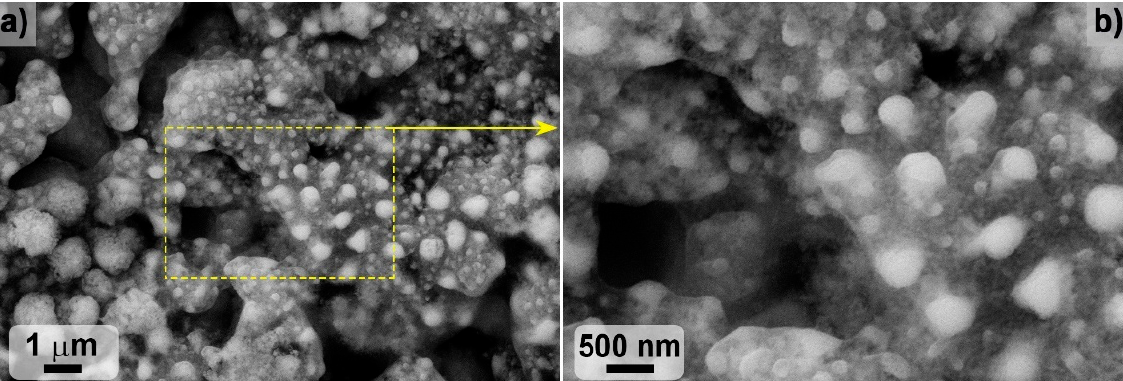
Figure 9. ( a ) ZHSC surface microstructure after thermochemical treatment; ( b ) SEM, accelerating voltage 20 kV.